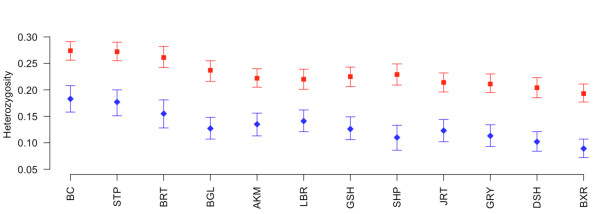
Average heterozygosity of SD and non-SD CNVs. Red squares and blue diamonds denote average heterozygosity for CNV regions associated with SDs and non-SDs, respectively. Vertical lines represent 95% confidence intervals. Breed abbreviations are described in Figure 2.